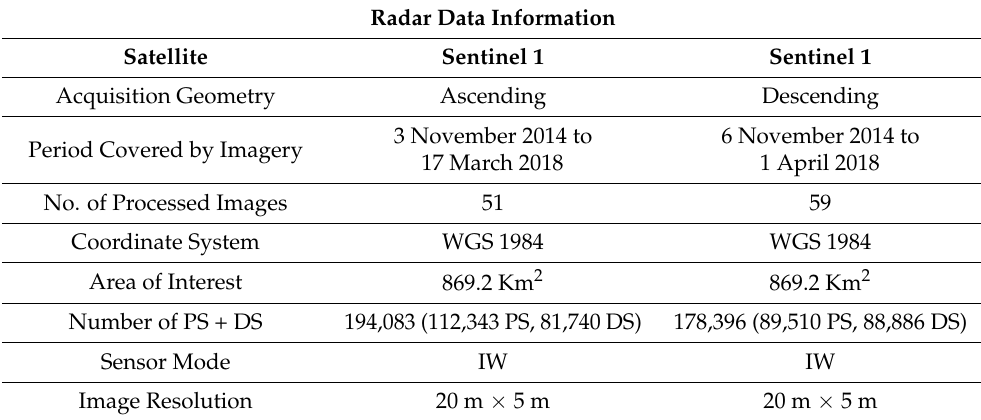
Table 1. Details of the processed satellite InSAR data.